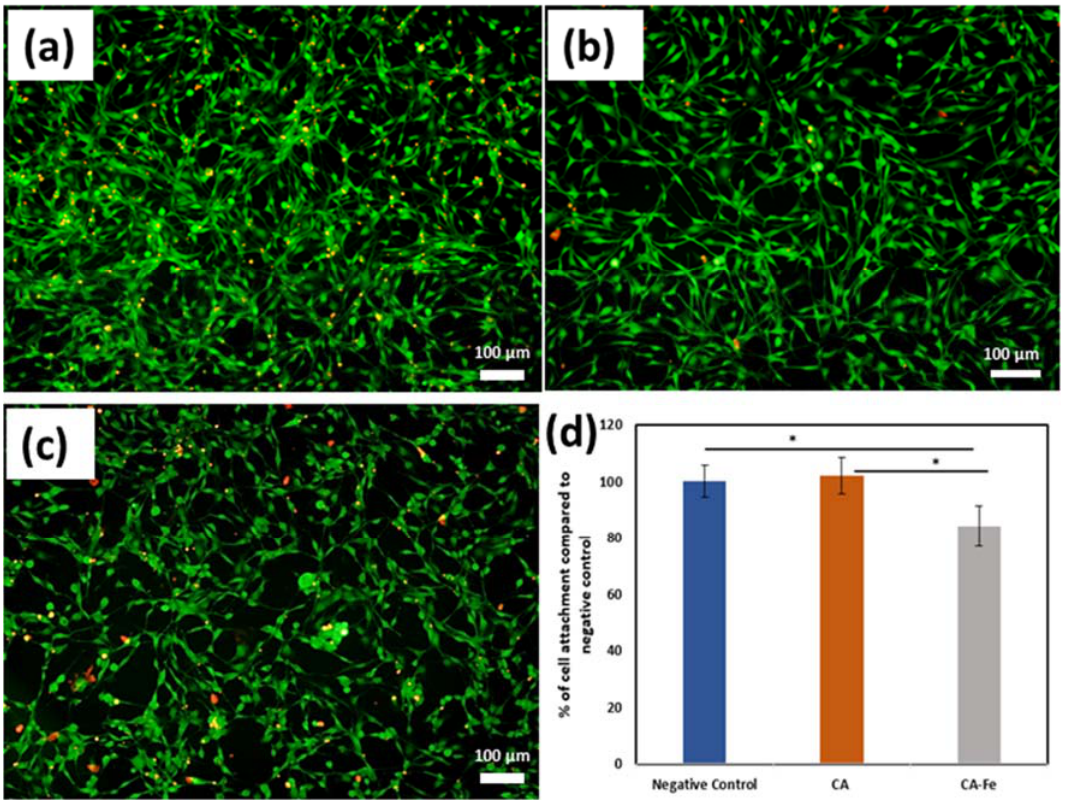
Figure 8. Fluorescent images of hFOB cells cultured as ( a ) negative control, or in presence of preconditioned medium of ( b ) CA, or ( c ) CA/Fe mats for 7 days. Calcein AM (green) indicates live cells while ethidium homodimer (red) indicates dead cells (scale bar =100 μ m, magnification = 10×. ( d ) Cell attachment assay on CA and CA/Fe mats. A non-significant level of hFOB cell attachment is observed between CA mats and negative controls. Results are represented as means ± SD, * p ≤ 0.05; n = 8; Student’s t test.